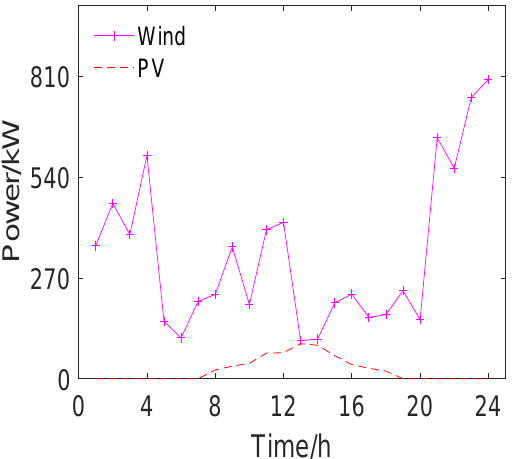
Figure 7. Empirical values of wind and photovoltaic